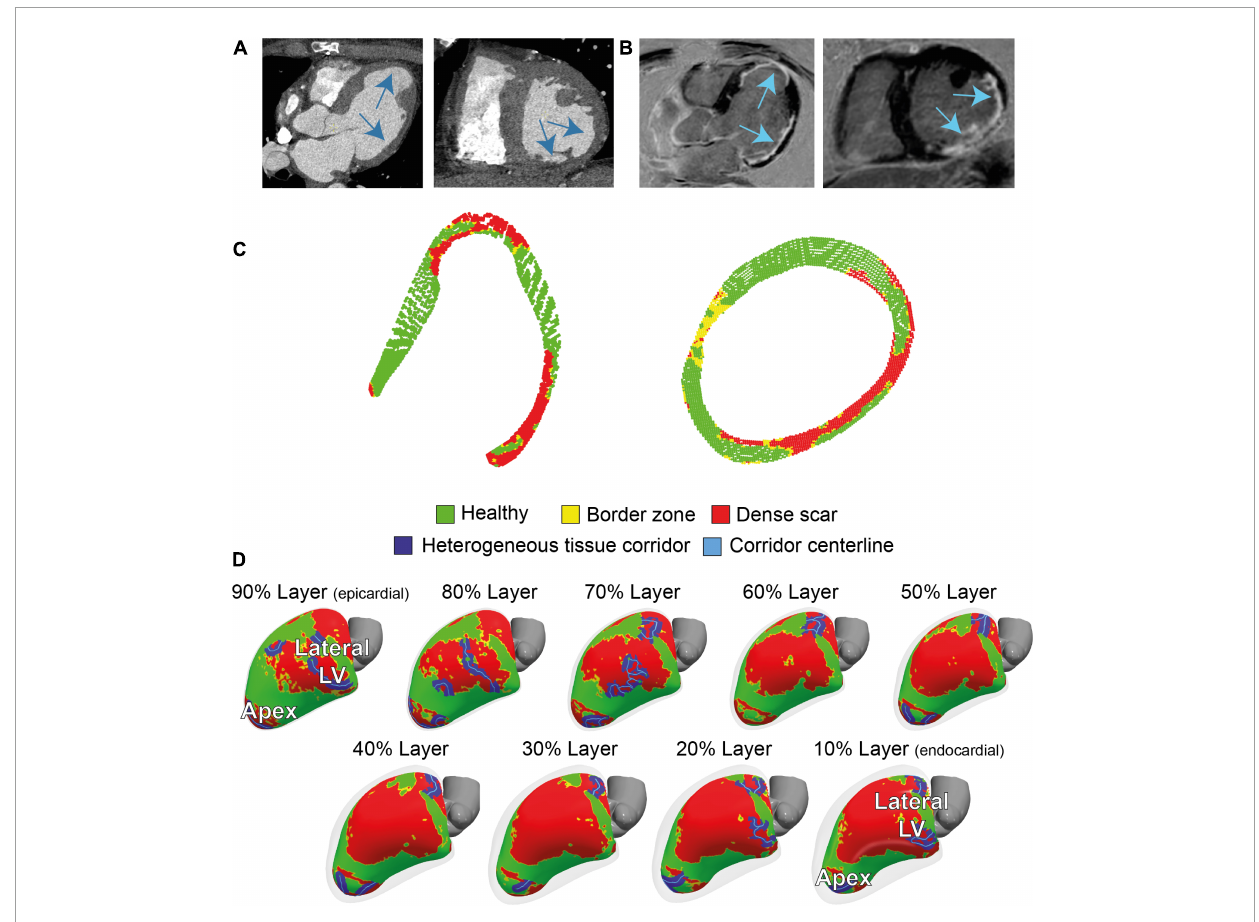
FIGURE2 Cardiac imaging of the patient prior to the ablation procedure. (A) Contrast-enhanced dual-source computed tomography (CT), performed for anatomical reference showing wall thinning in the apical aneurysm and laterobasal aspect of the left ventricle (LV). (B) 3D dark-blood late gadolinium enhancement cardiac magnetic resonance imaging (LGE CMR) LGE CMR showing areas with hyperenhancement in the laterobasal and apical aspects of the LV. (C) Two cross-sectional views of LV scar, detected by 3D dark-blood LGE CMR. (D) CMR-derived healthy and scar tissue, including corridors and their centerlines, depicted in nine transmural layers (interlayer distance approximately 0.8 mm) of the ventricular myocardium. Colors correspond to colors in panel (C)